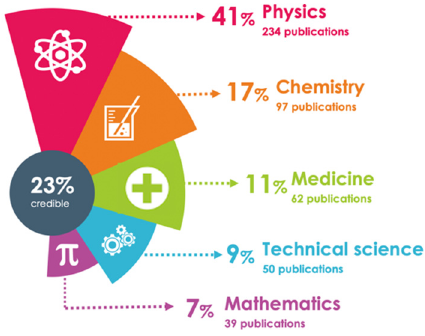
Figure 11. Top-five academic disciplines based on the number of credible publications.